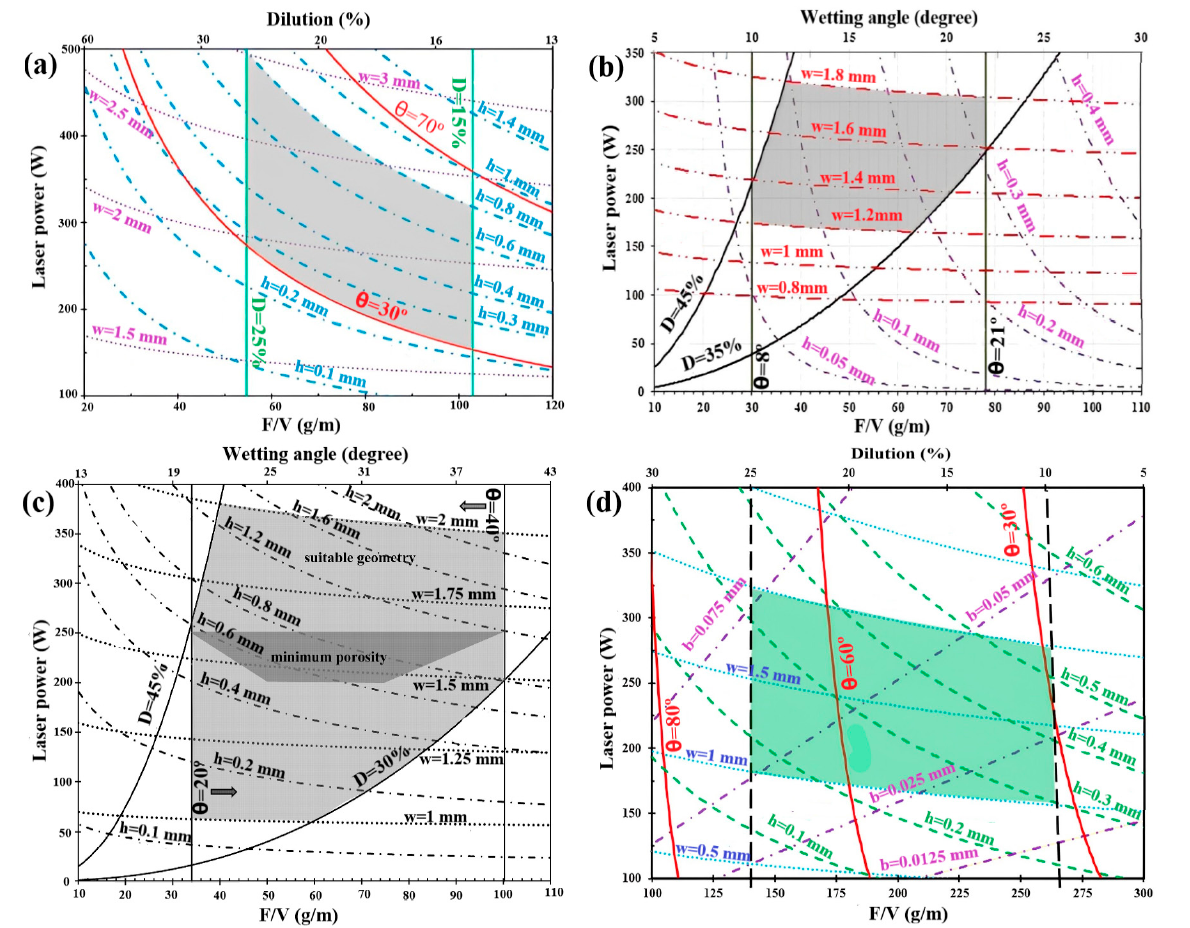
Figure 3. Processing map of laser cladding. ( a ) The processing map for coaxial laser cladding of NiCrAlY powder on Inconel 738 nickel-based alloys. Reprinted with permission from Ref. [71]. 2016, Elsevier. ( b ) The processing map for laser cladding of Inconel 625 powder on ASTM A592 steel. Reprinted with permission from Ref. [72]. 2020, Elsevier. ( c ) The processing map for laser cladding of WC-12Co powder on AISI 321 steel. Reprinted with permission from Ref. [73]. 2017, Elsevier. ( d ) The processing map for laser cladding of Ti-6Al-4V alloy on Ti-6Al-4V. Reprinted with permission from Ref. [74]. 2018,